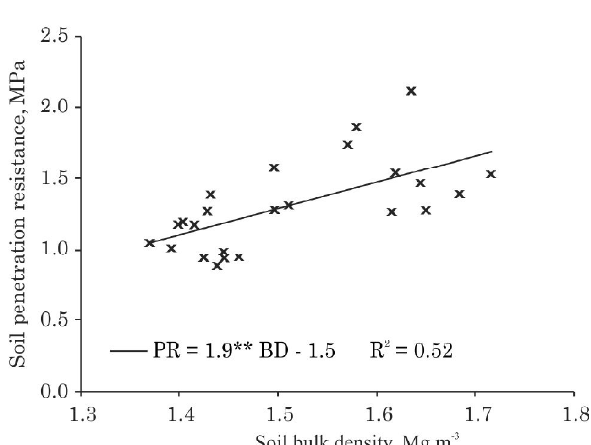
Figure 3. Penetration resistance in function of soil bulk density, in the soil no-subsoiling and subsoiling treatments in a citrus orchard (n = 24). The PR was evaluated in soil samples under controlled moisture tension (10kPa).